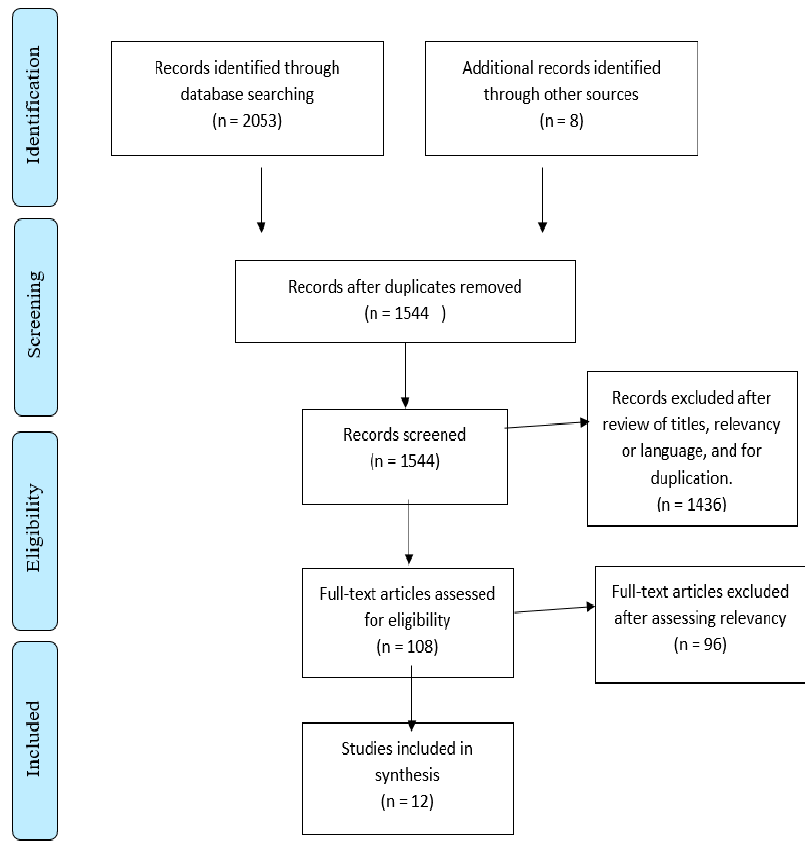
Figure 1. Literature Search Process: PRISMA Diagram.